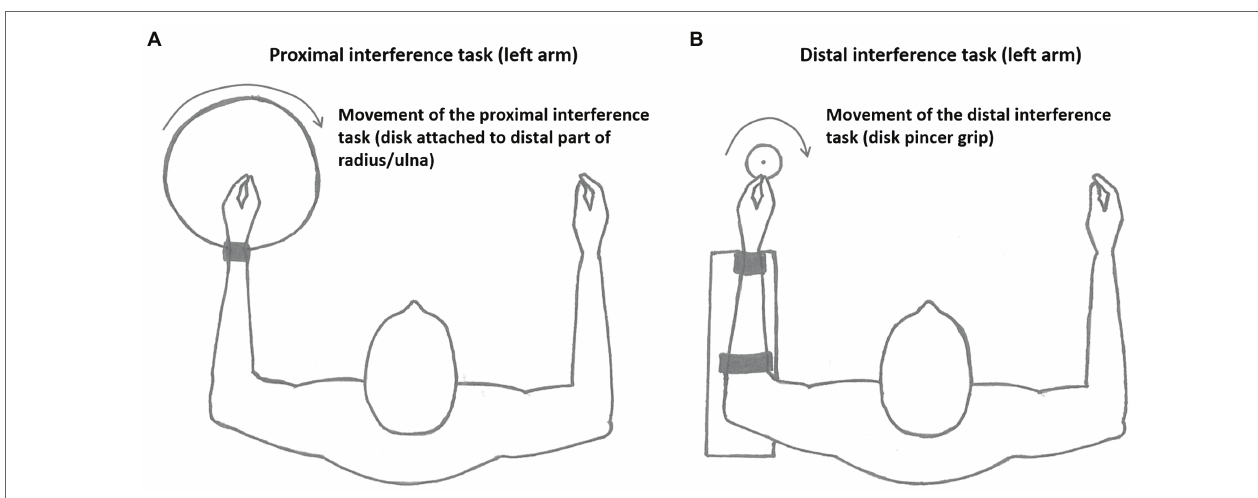
FIGURE 3 | Illustration of the experimental setup of the (A) proximal interference task and the (B) distal interference task performed with the non-dominant arm. The proximal and distal interference tasks were performed in simultaneously with the primary task in the four different condition: (1) proximal primary task simultaneously with proximal interference task (homologous effectors), (2) proximal primary task simultaneously with distal interference task (non-homologous effectors), (3) distal primary task simultaneously with distal interference task (homologous effectors), and (4) distal primary task simultaneously with proximal interference task (non-homologous